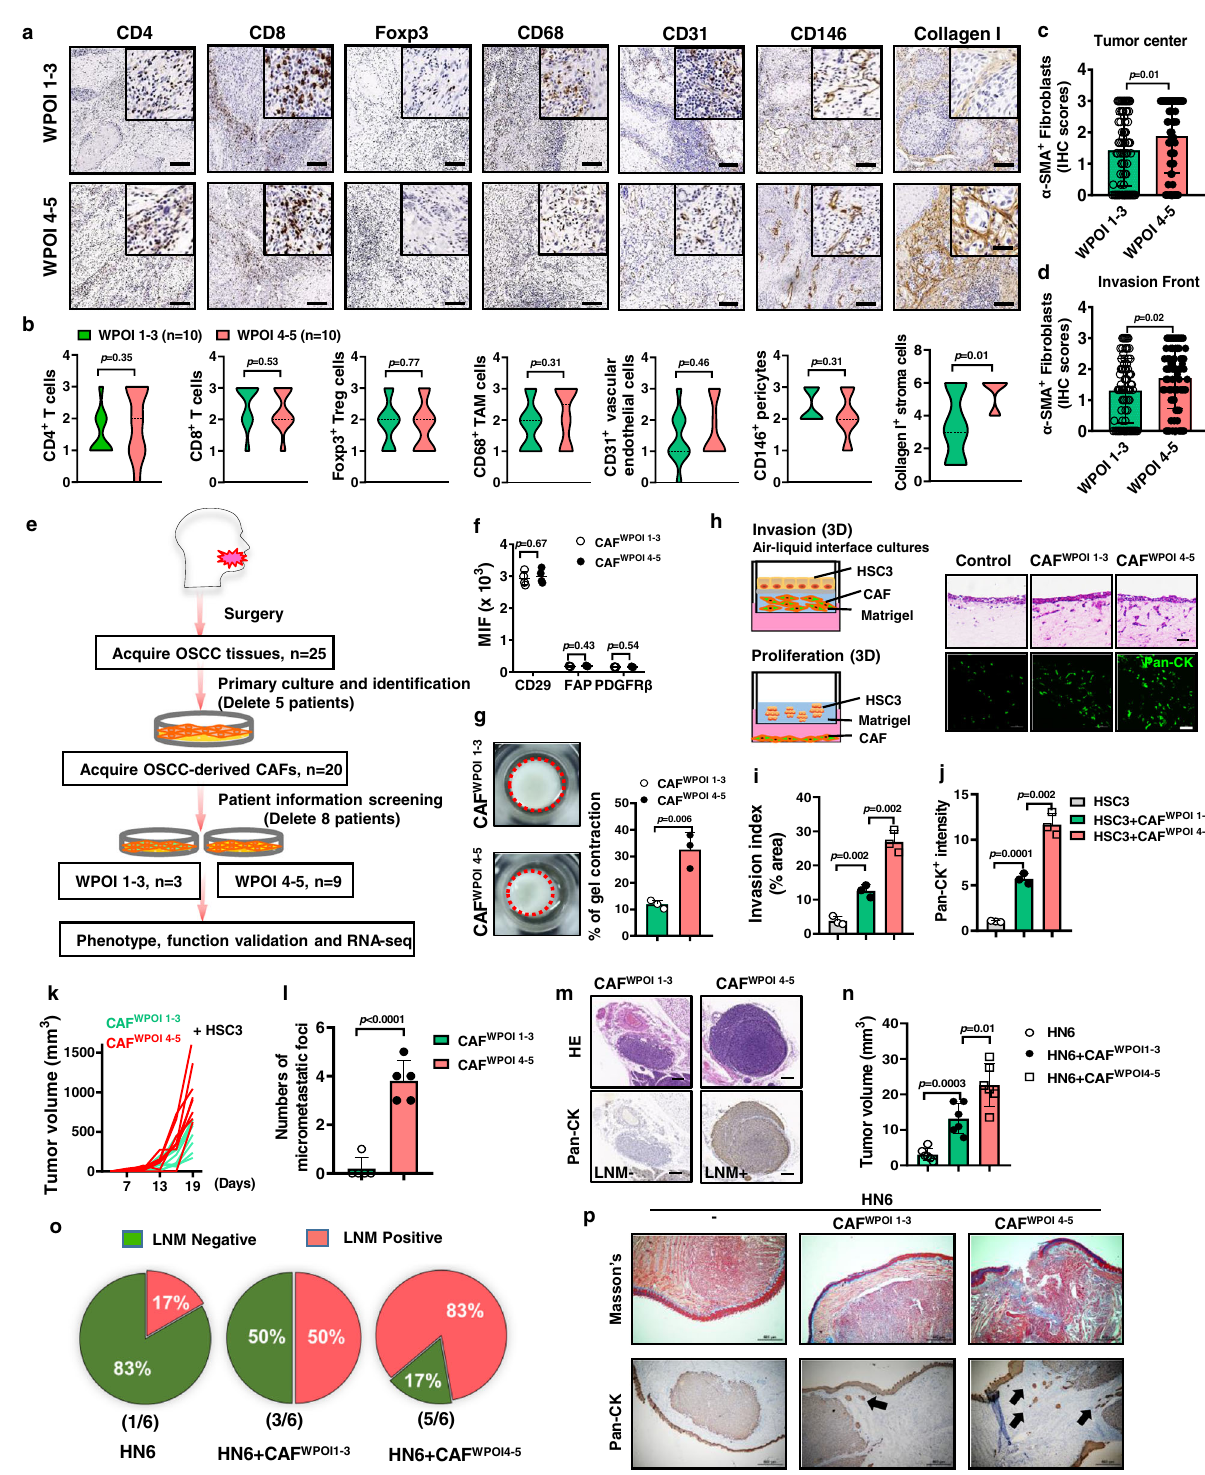
western blot (Fig.4f)con fi rmed ablationof OXTR in editedcells, which effectively reduced expressionof PDGFR- β and N-cadherinin OXTR High CAFs. Considering that the members of the OXTR/AVPR family are conserved and share a high degree of sequence similarity 34 , we determined AVPR1 (V1aR), AVPR2 (V2R) and AVPR3 (V1bR) levels in response to OXTR knockdown, however,the expression levels of three AVPR family member remained unchanged (Supplementary Fig.